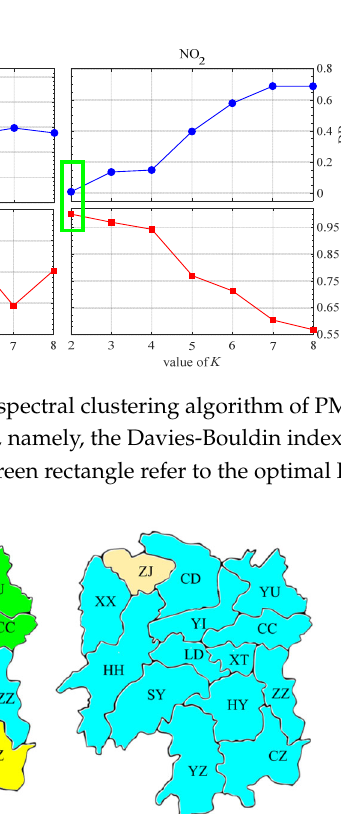
Figure 6. Diagram for the correlation matrix of topological parameters. The subscripts 1, 2, and 3 of the three parameters represent AQI, PM 2.5 , and NO 2 , respectively.